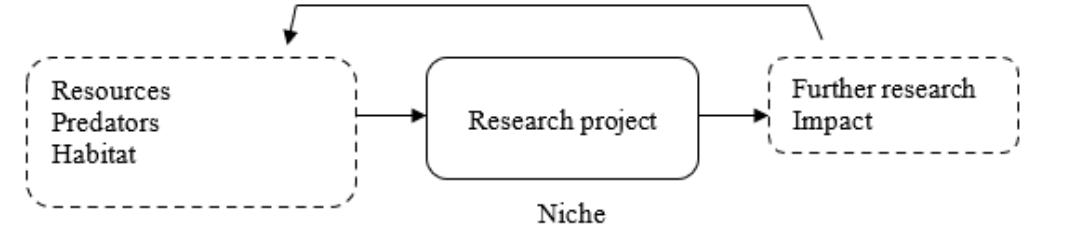
Figure 1. Schematic of research